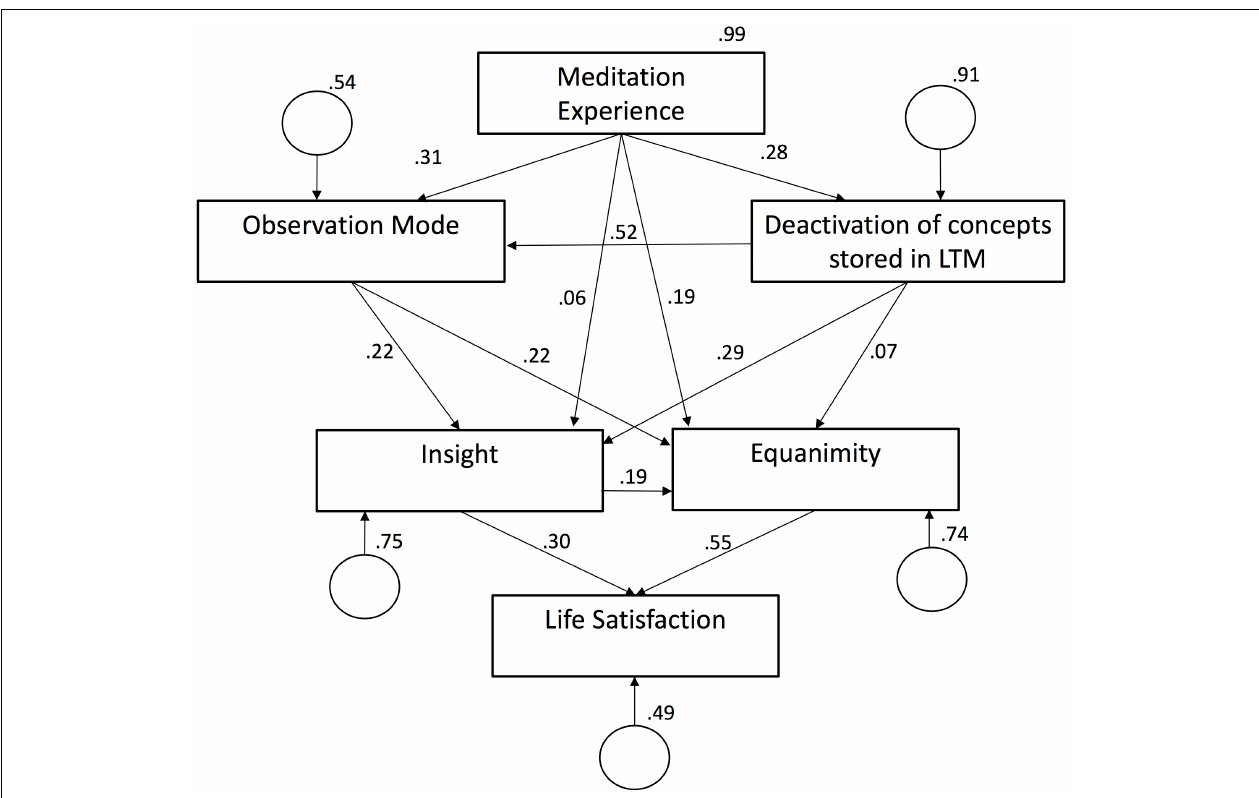
FIGURE 3 | Standardized path coefficients (and p -values) for the proposed model. χ 2 = 0.819 ( df = 3, p = 0.845), GFI = 1.00, NFI = 1.00, CMIN/DF = 0.27, RMSEA < 0.001, p-close = 0.89; N =